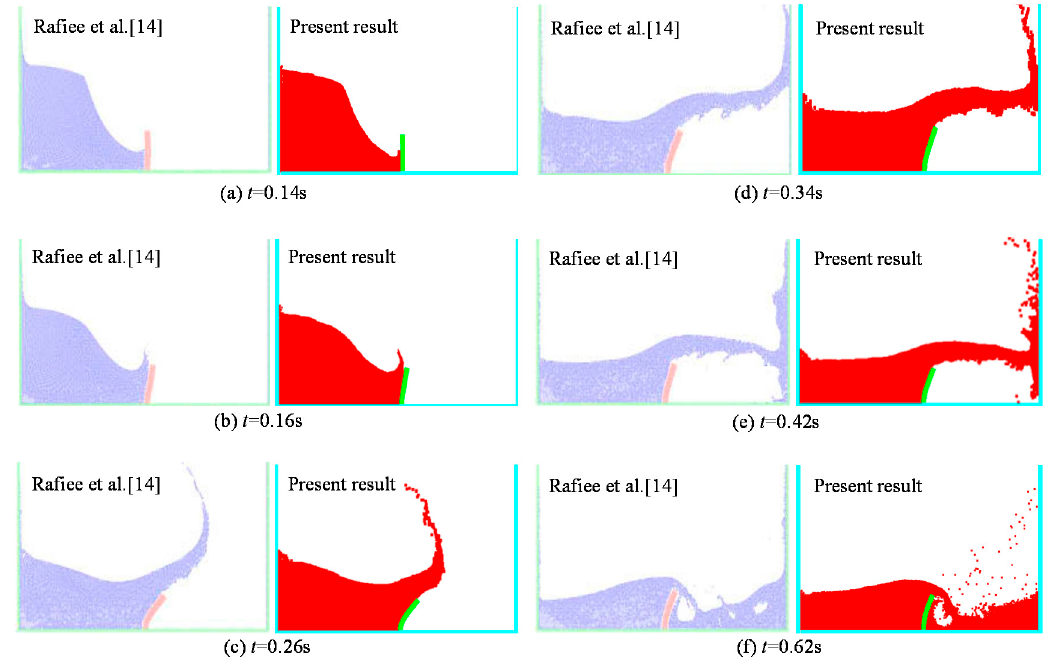
Figure 5. Comparisons of free surface and corresponding structure deformation using different numerical methods.